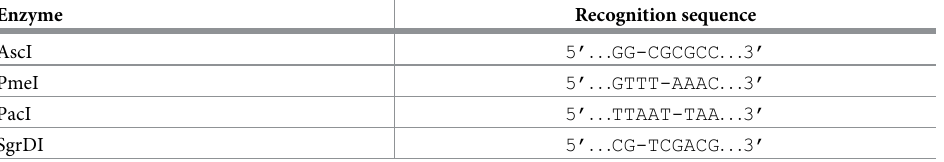
Table 1. Restriction enzymes used in this study. The names and recognition sequences (restriction sites) of the restriction enzymes that were used to produce experimental dually labeled DNA barcodes. Note that the complement recognition sequences of each listed recognition sequences is a palindromic and that these enzymes cleave both strands of the DNA molecule. This means that when a plasmid reference sequence is searched for the recognition sequence, only one of the DNA strands has to be considered and only the 5’ to 3’ direction.